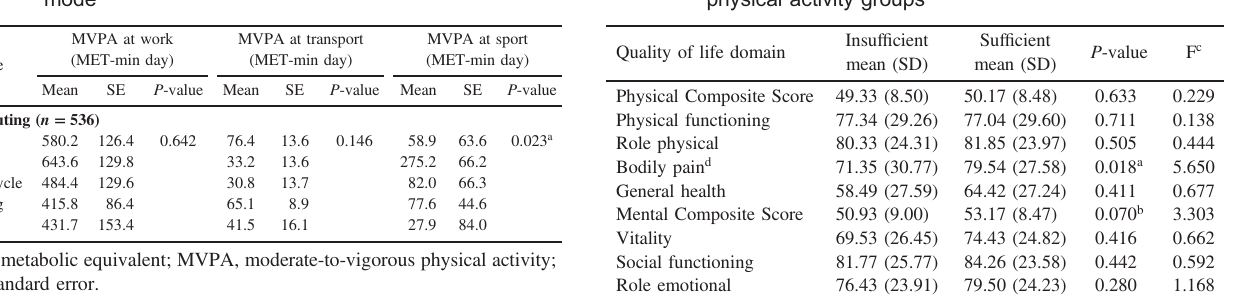
Table 2. The pattern of physical activity domains by commuting